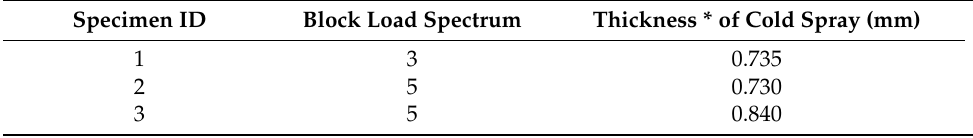
Table 2. The block loading spectrum used in the fatigue tests and the cold spray